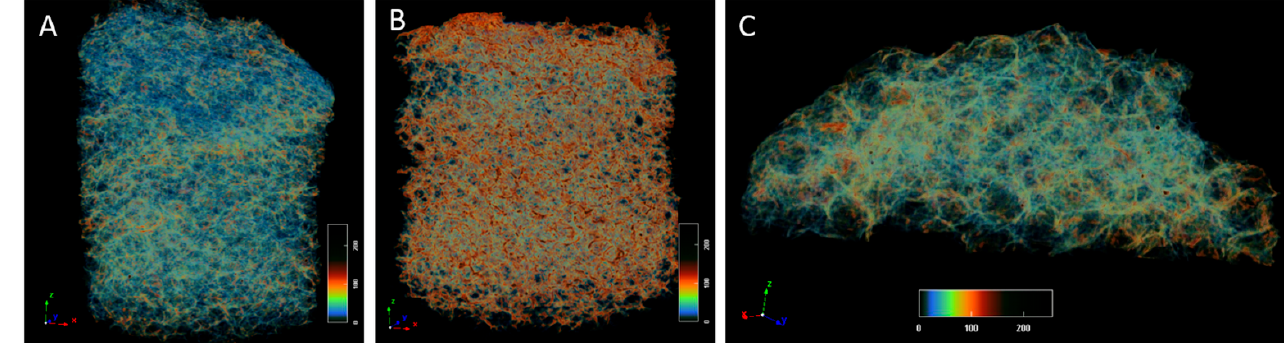
Figure 1. Volume rendering of the SF scaffolds acquired by micro-CT: ( A ) SSF; ( B ) SSFtime; and ( C ) SSFc.